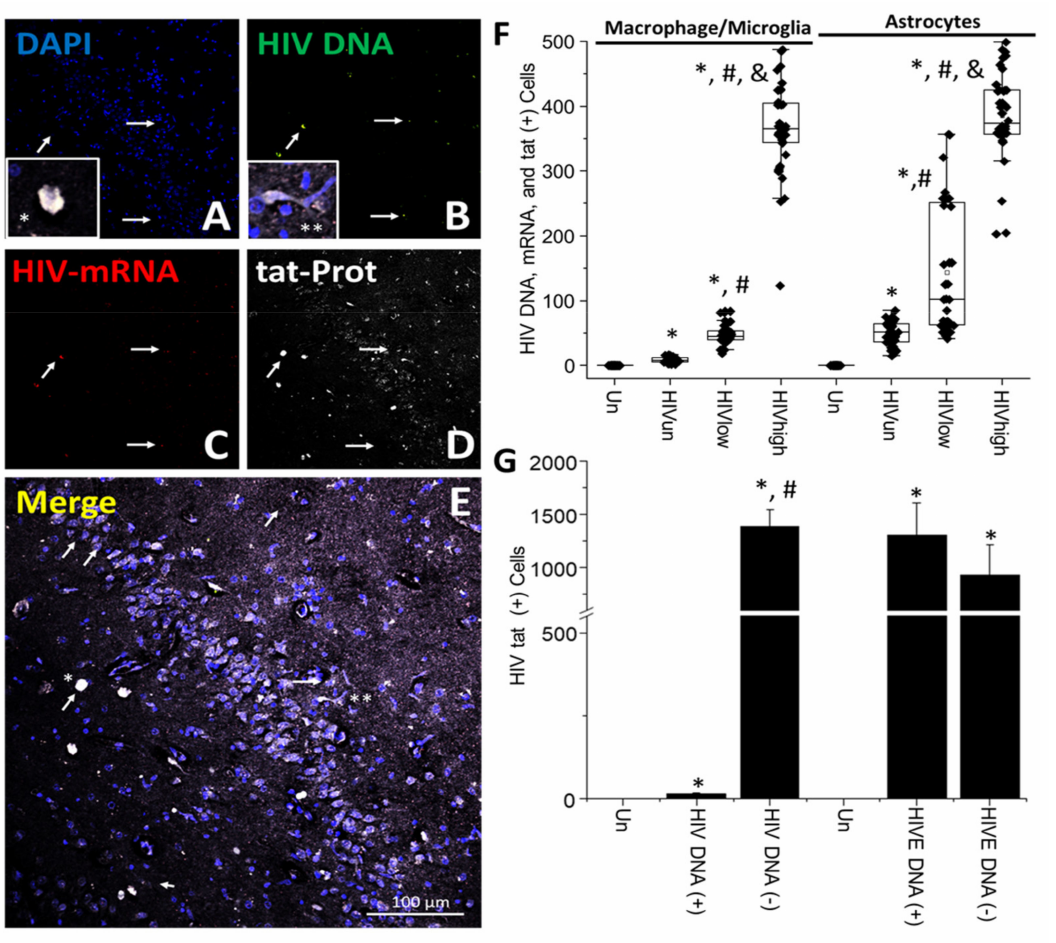
Figure 7. HIV-tat protein is expressed within the CNS, even in the ART era. ( A – E ) Representative confocal images show the expression and distribution of the tat protein in the HIV-infected cells and surrounding uninfected cells. Labeling corresponds to ( A ) DAPI, ( B ) HIV DNA, ( C ) HIV-mRNA, ( D ) HIV-tat protein showing diffusion from HIV DNA-positive cells into neighboring uninfected